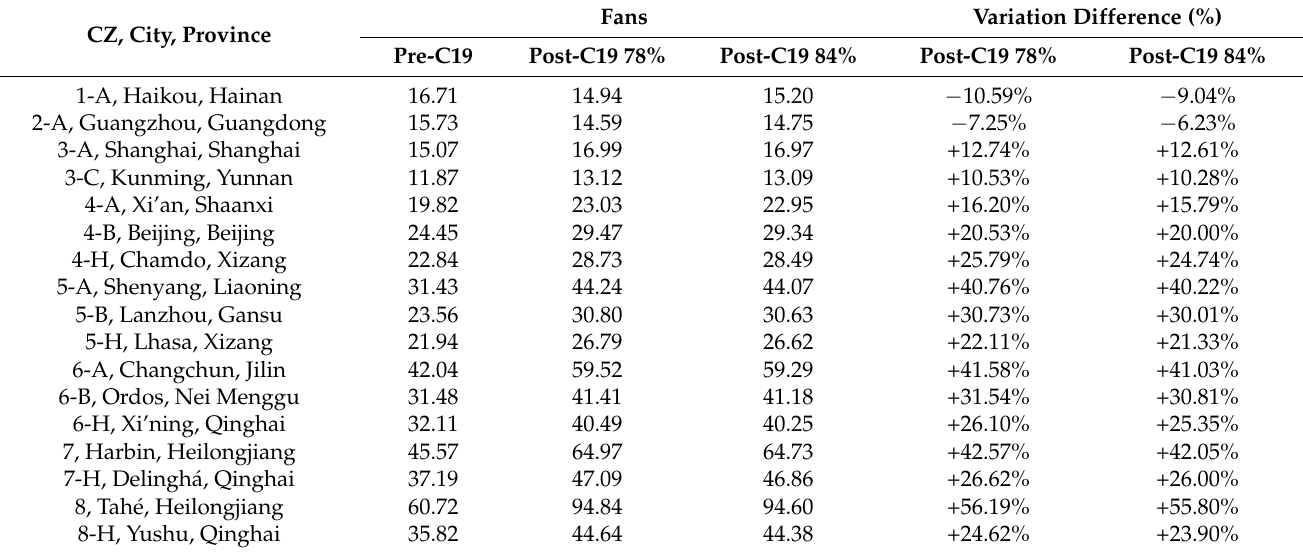
Table A1. Fans EUI per location in pre- and post-C19 scenarios.